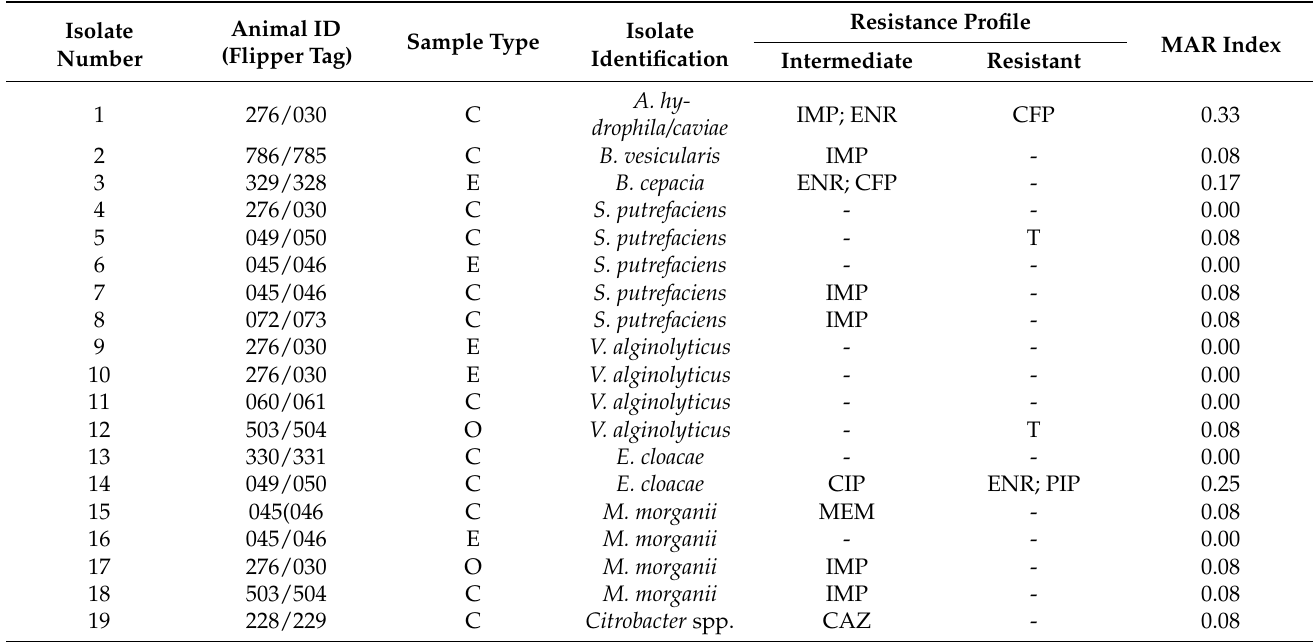
Table 2. Selected isolates’ antimicrobial resistance